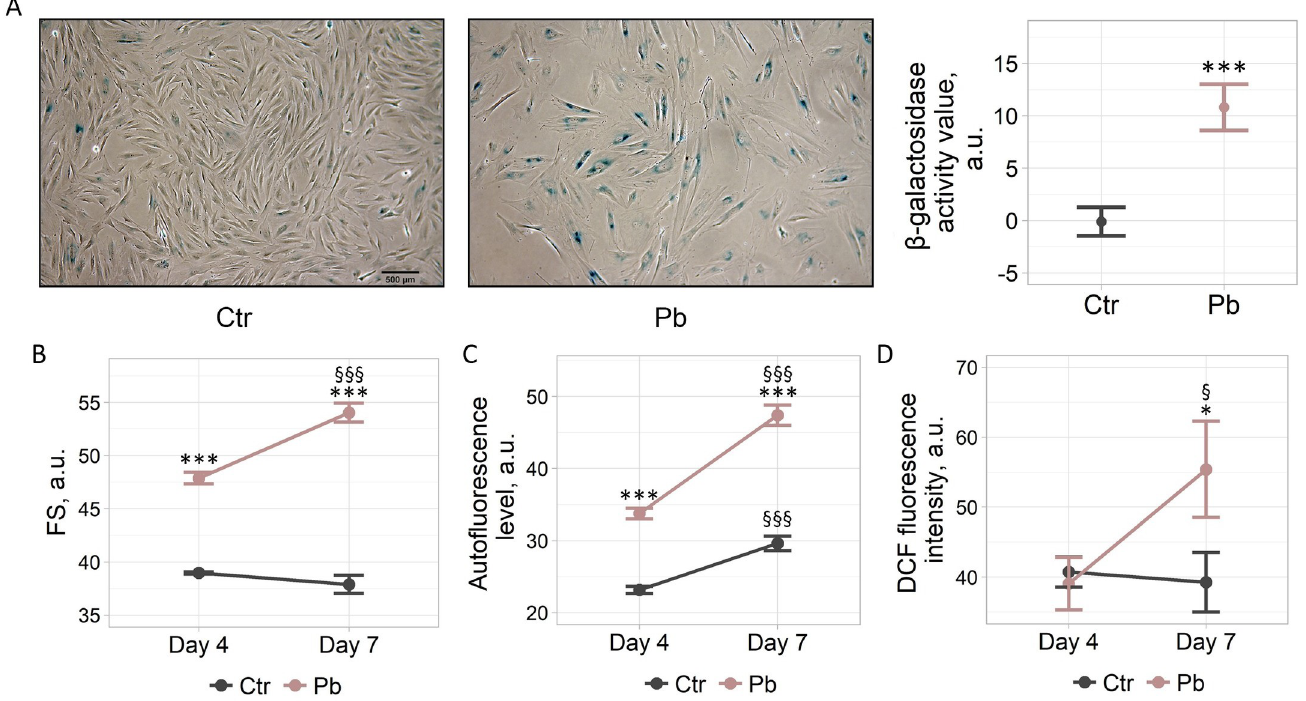
Fig 2. Pb causes the appearance of premature senescence markers in hMESCs. “Ctr”–control cells. “Pb”–Pb-treated cells. (A) SA- β -Gal staining of Ctr and Pb- treated hMESCs. Scale bar is 500 μ m and valid for all images. (B, C, D) Cell size, cell autofluorescence and intracellular ROS levels, respectively, determined by flow cytometry. Forward scatter (FS) reflects the average cell size. Intracellular ROS levels were detected after H 2 DCF-DA staining. Representative results of three independent experiments are shown.